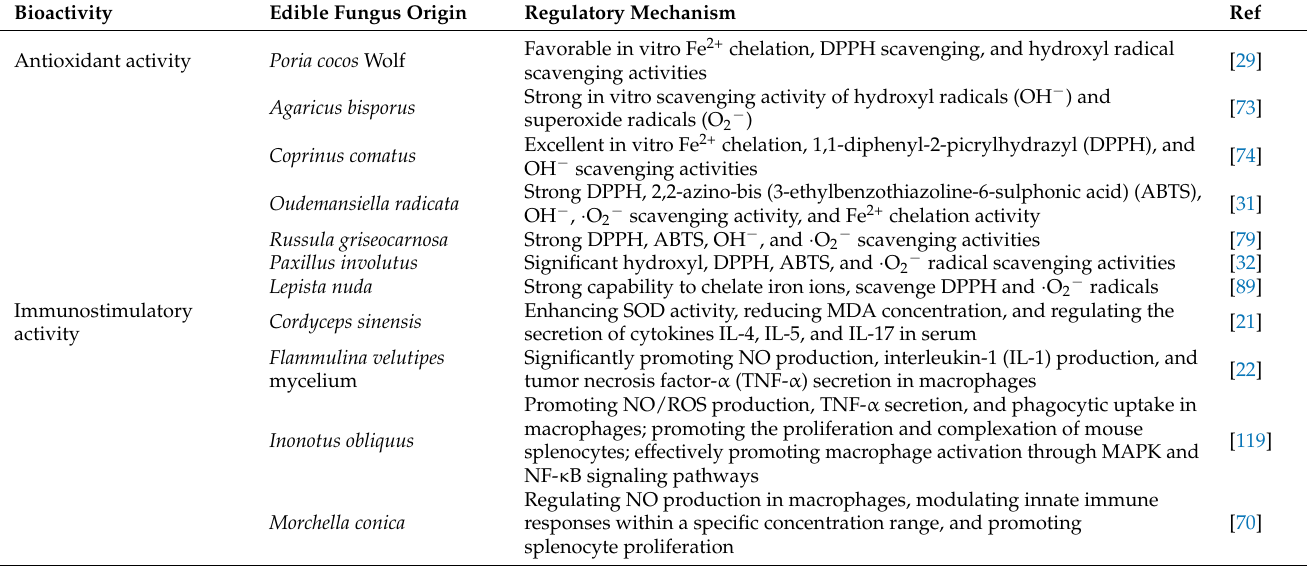
Table 3. Bioactivity and mechanism of edible fungus